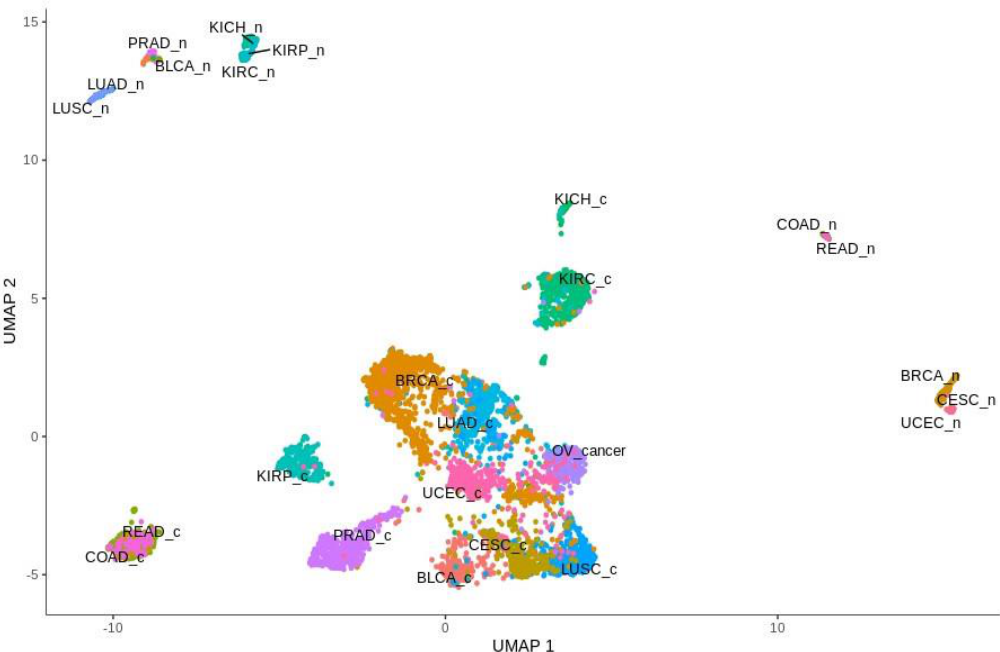
Figure 1. Spatial profiling of BLCA, BRCA, CESC, COAD, KICH, KIRC, KIRP, LUAD, LUSC, OV, PRAD, READ and UCEC accompanied by normal tissue samples with respect to expression of Notch core components. Tumors are designated with a “c” ending, while normal tissues are designated with an “n” ending.